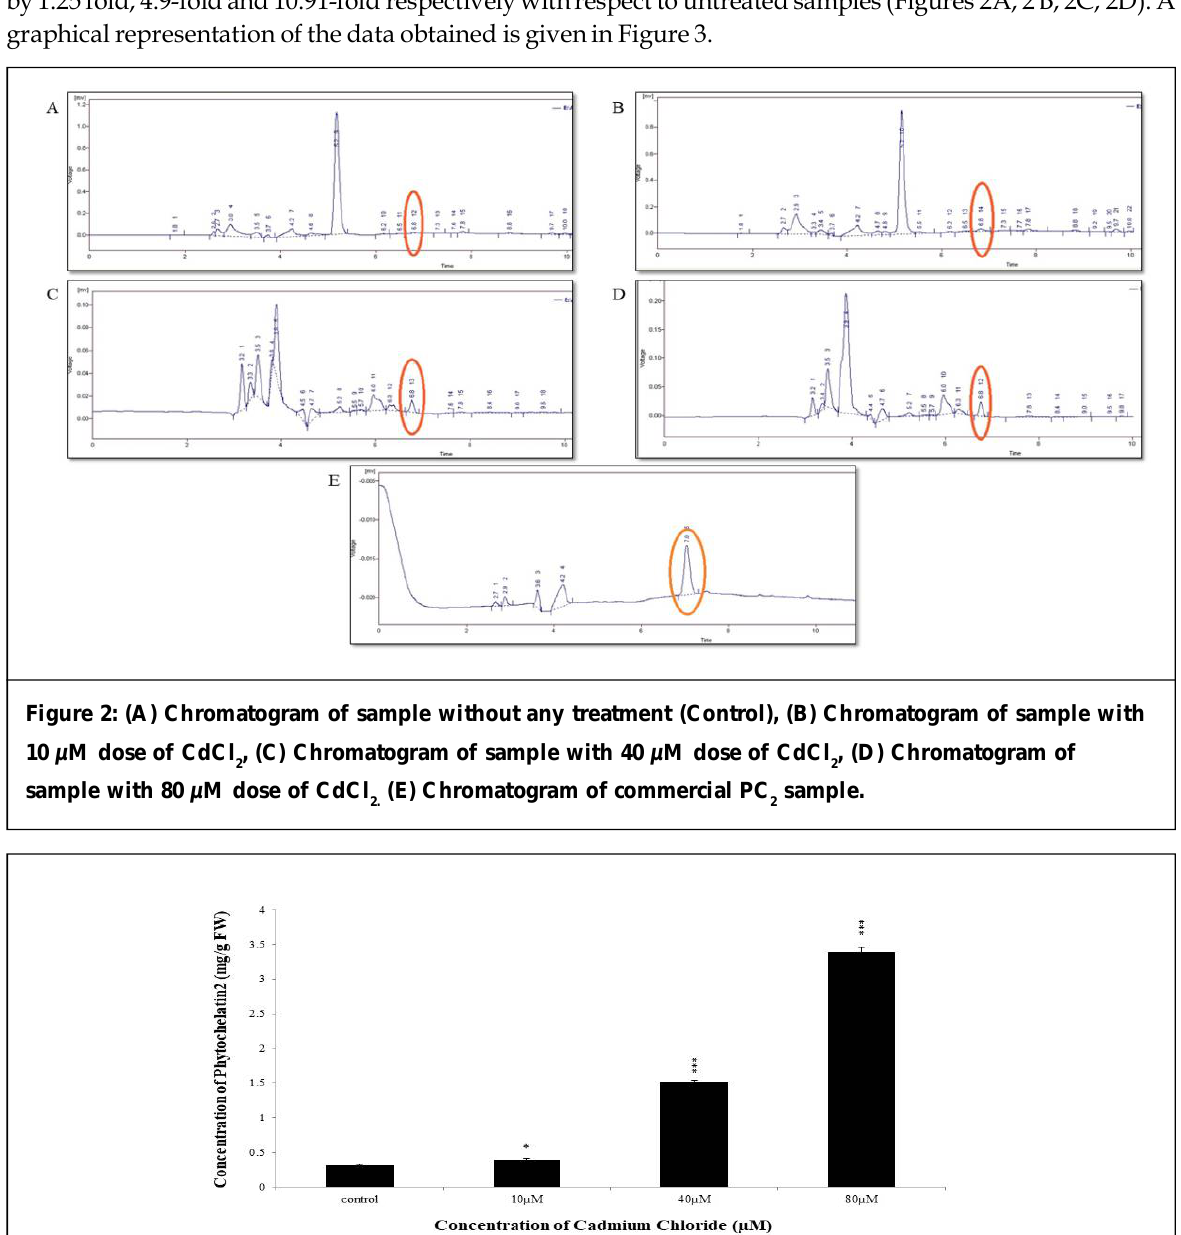
Figure 3: Graphical representation of PC with respect to different doses of CdCl Note: Asterisks denote the level of significance; * p  0.05, ** p  0.01 and *** p 